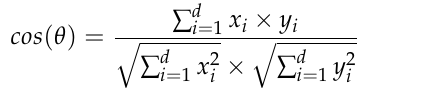
Figure 6. Comparison between the models before and after the mesh mapping method in the two- dimensional case: ( a ) initial model; ( b ) mesh-mapped model.